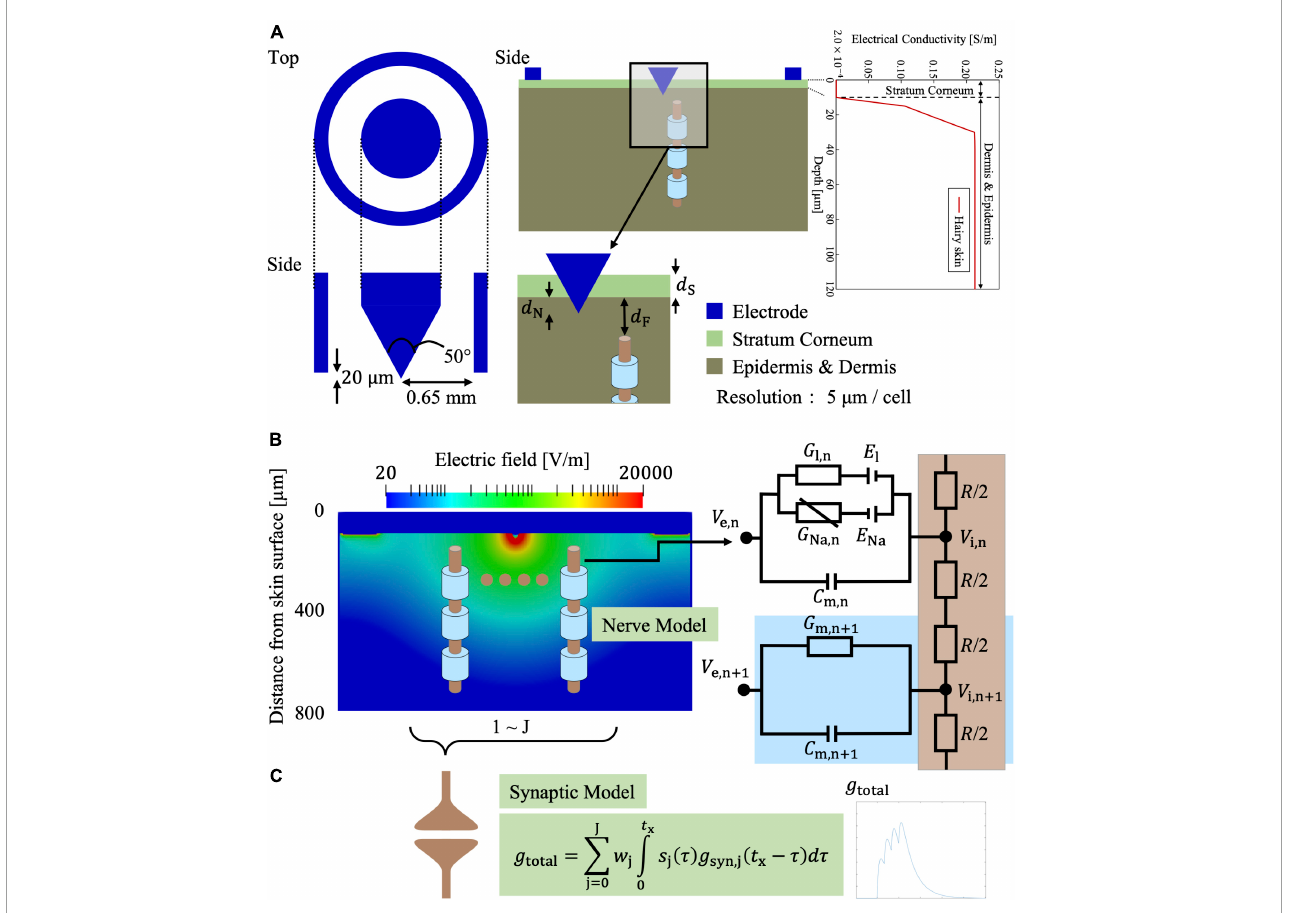
FIGURE3 Multiscale electrical stimulation model with synaptic effects for intraepidermal electrical stimulation (IES) of small fibers (A δ -fiber in the illustration). (A) IES electrode and layered skin model. (B) Electric field distribution in the skin on a transversal plane for an injection current of 20 µ A. (C) The afferent spikes of the stimulated small fiber are computed and integrated into a synaptic